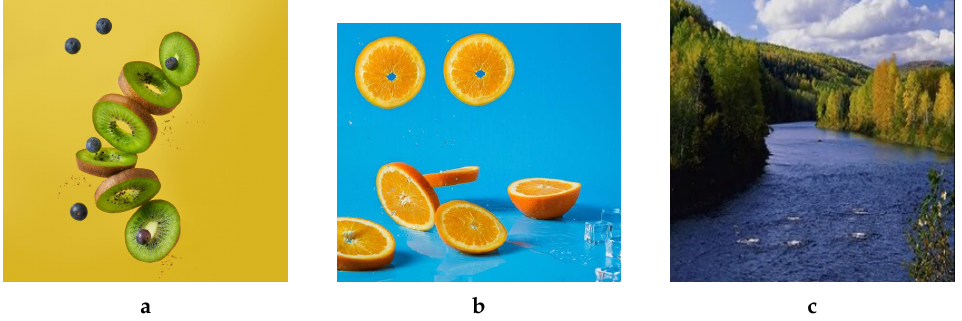
Figure 13. Examples of additional forged images along with the sizes (The first two images derived from images found on https://unsplash.com/accessed:March09,2022 while the third one derived from an image taken from CASIA dataset [35]). ( a ) 1024 × 1024, ( b ) 502 × 457, ( c ) 256 ×